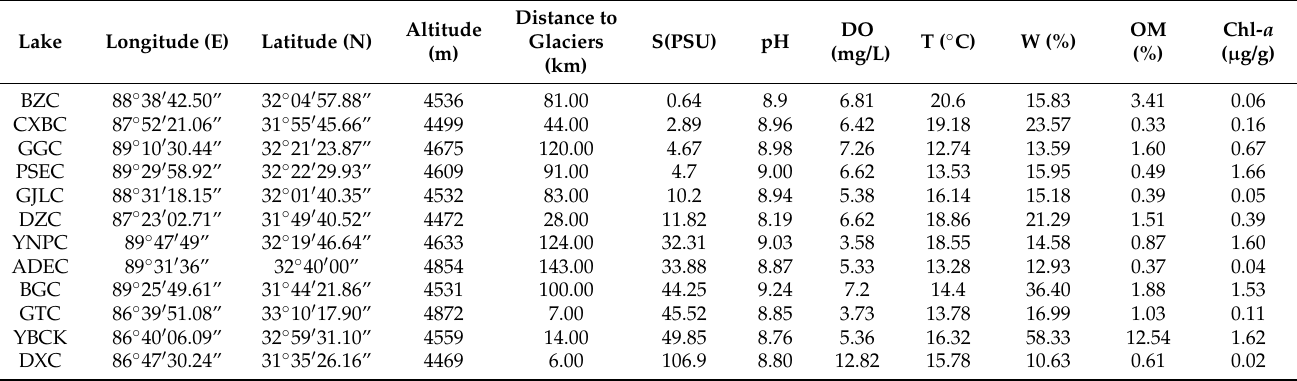
Table 1. Geographic parameters and physicochemical characteristics of the 12 sampled lakes on the Tibetan Plateau,